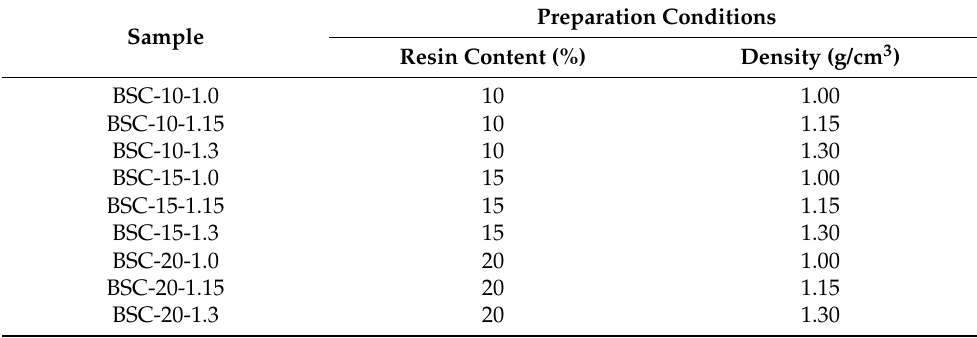
Figure 1. Schematic illustration of BSC preparation. Note: ( a ) Defibering; ( b ) Dipping into the PF resin; ( c ) Hot pressing; ( d ) BSC. Table 1. BSC preparation conditions.